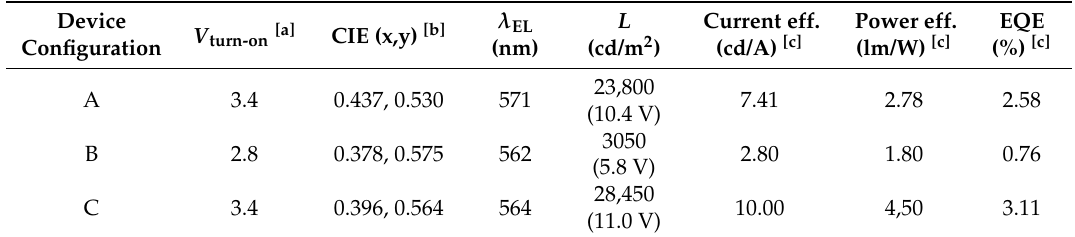
Table 1. Characteristics of OLEDs fabricated with Fluo-1 and Fluo-2 .